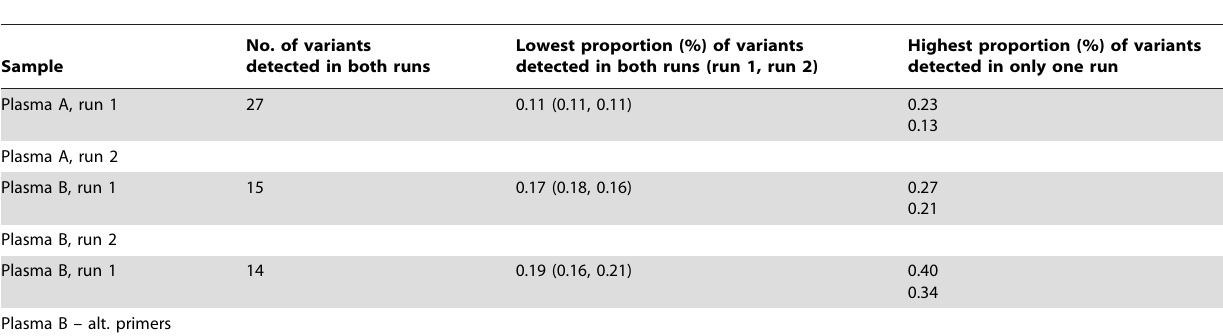
Table 2. Limit of detection of repeatedly detected virus variants in samples analyzed using original primers and alternative PCR